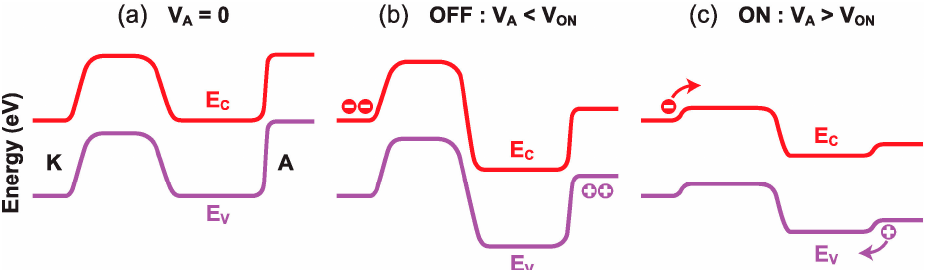
Figure 7. Typical profiles of the energy bands along the body as the anode voltage increases: ( a ) equilibrium at V A = 0, ( b ) blocked I OFF state with 0 < V A < V ON , and ( c ) I ON state with V A > V ON . The band diagram also depends on the depth within the body, being a little different at the front and back interfaces.